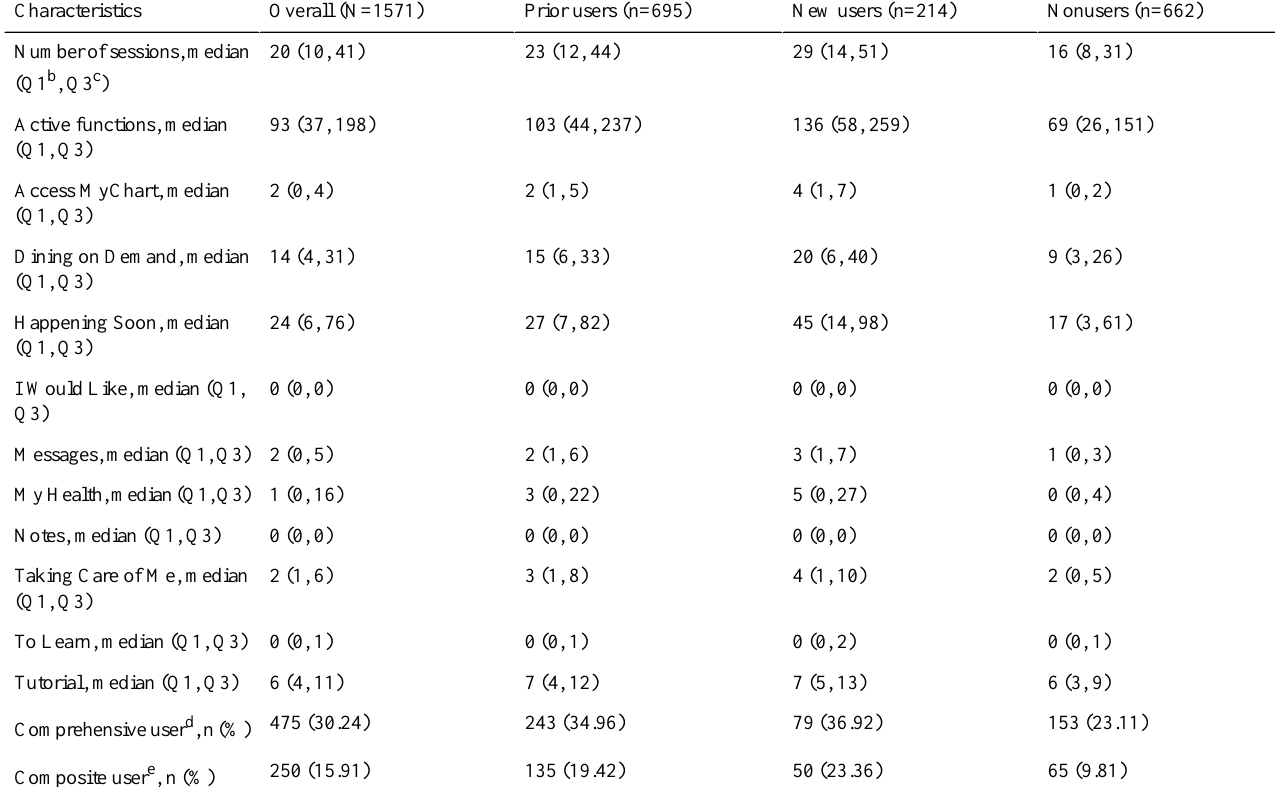
Table 2. Frequency of MyChart Bedside use by MyChart user status a